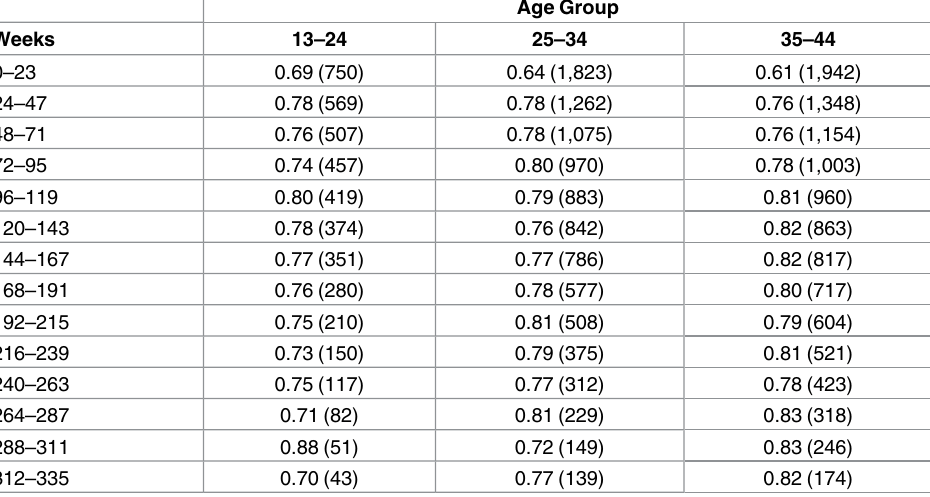
Table 3. Proportion of Patients with Virologic Suppression ( (cid:20) 400 copies/mL), by Age Group and Weeks from cART